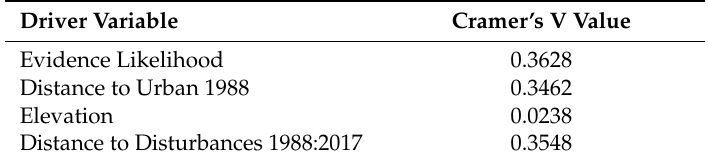
Table 2. Driver variable’s Cramer’s V values for final 1988:2017 model including only the cultivated lands